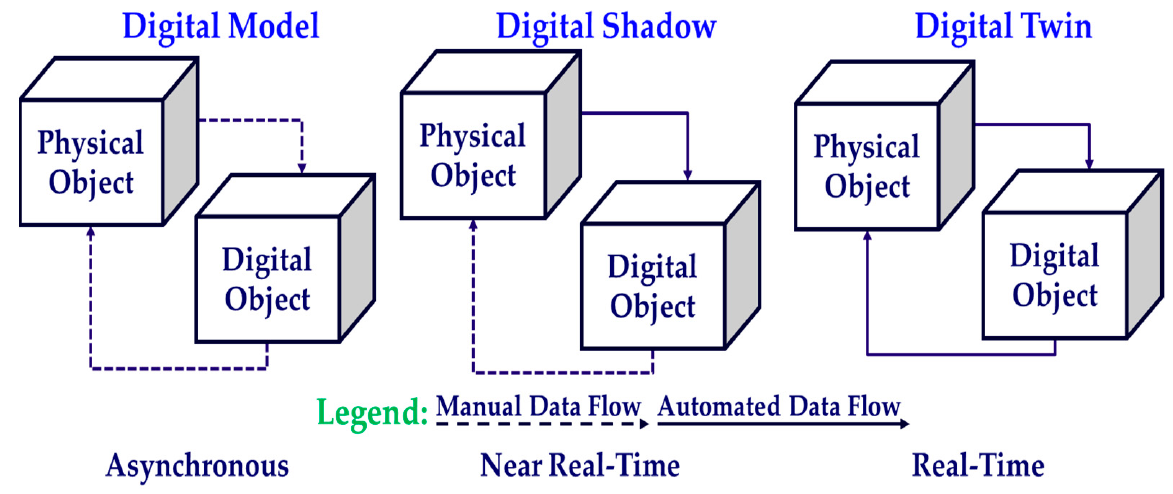
Figure 3. From left to right: Digital Model; Digital Shadow; Digital Twin, adapted from [24].